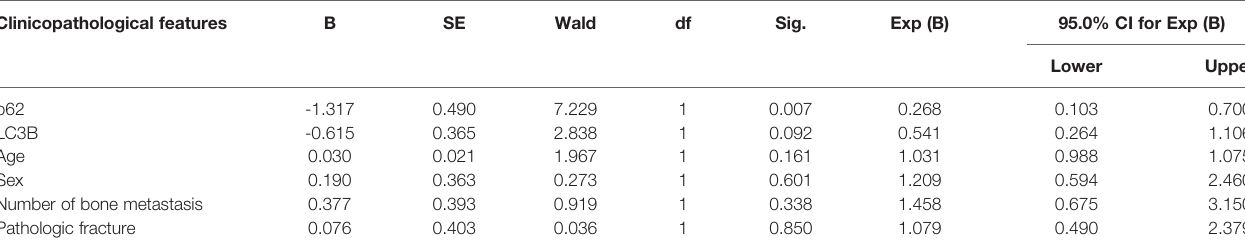
TABLE 2 | Cox regression analysis of overall survival in 62 patients with lung adenocarcinoma bone metastasis. Clinicopathological features B SE